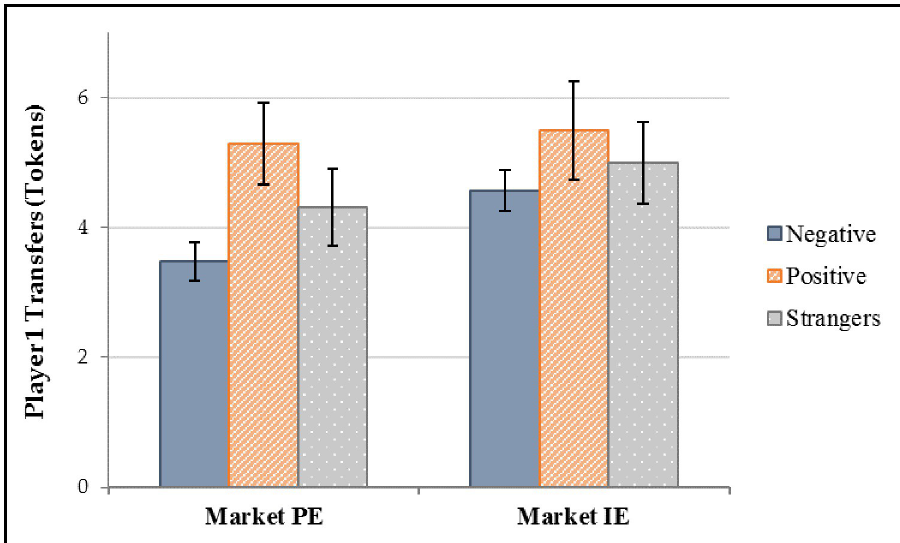
Fig 1. Player 1 transfers in Markets PE and IE by relationship typ. The error bars represent standard errors. Graph presents Player 1 transfers by different relationship types across treatments. The first set of bars represents Player 1 transfers in Market PE and the second set of bars represents Player 1 transfers in Market IE. Within each set of bars, from left to right, the bars represent negative relationships, positive relationships, and subject pairs with no trading